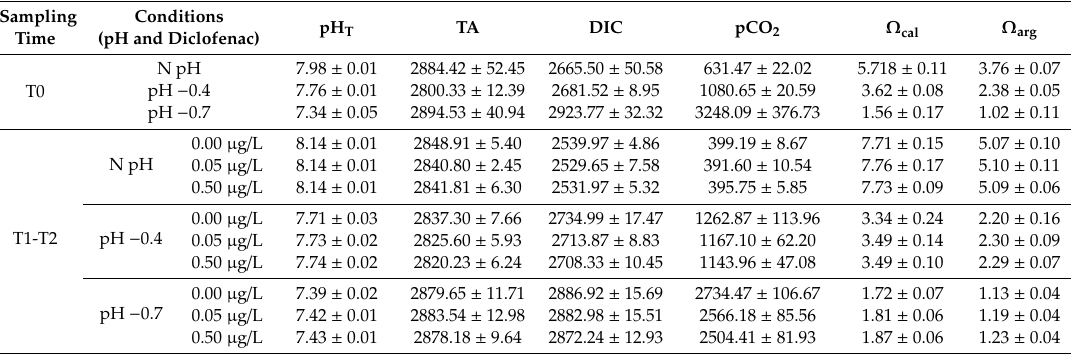
Table 1. Seawater carbonate chemistry parameters (mean values ± SE) throughout the experiment. TA = total alkalinity; DIC = total dissolved inorganic carbon; pCO 2 = CO 2 partial pressure; Ω = calcite saturation state; Ω = aragonite saturation arg cal